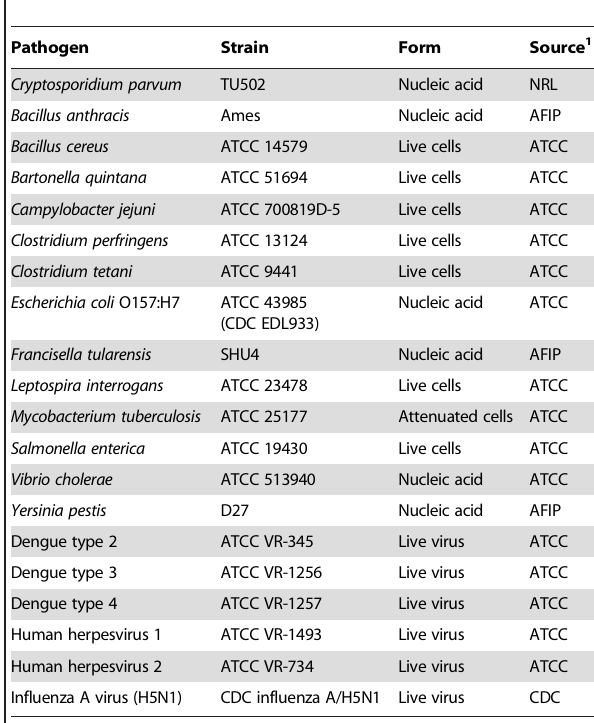
Table 1. Pathogens used as a source of nucleic acids for microarray